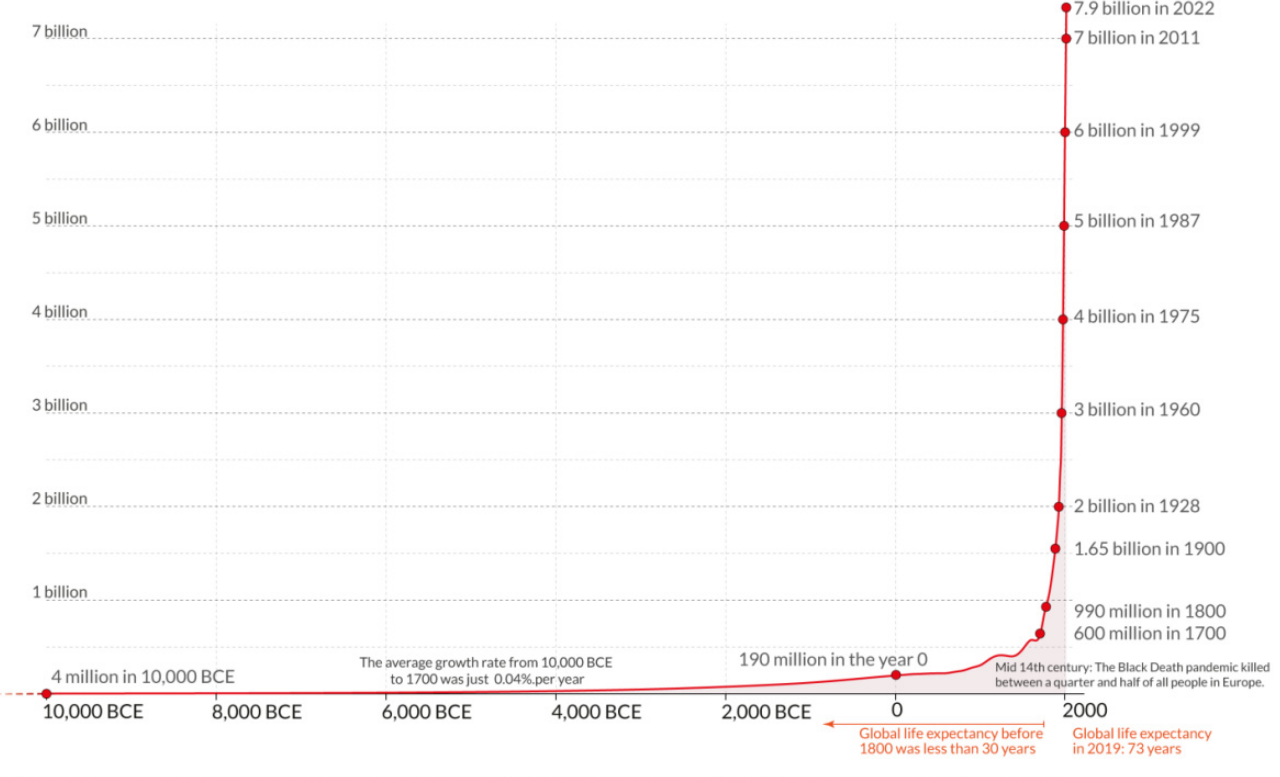
Figure 1. World Population growth over time (Source [2]).